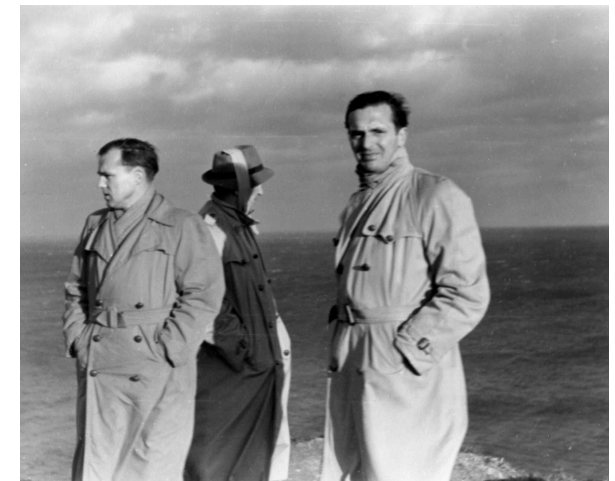
Figure 4. Professor Dr. Otto Hachenberg, director of the HHI, viewing the location for the prospective ionospheric station of Juliusruh, 1954.